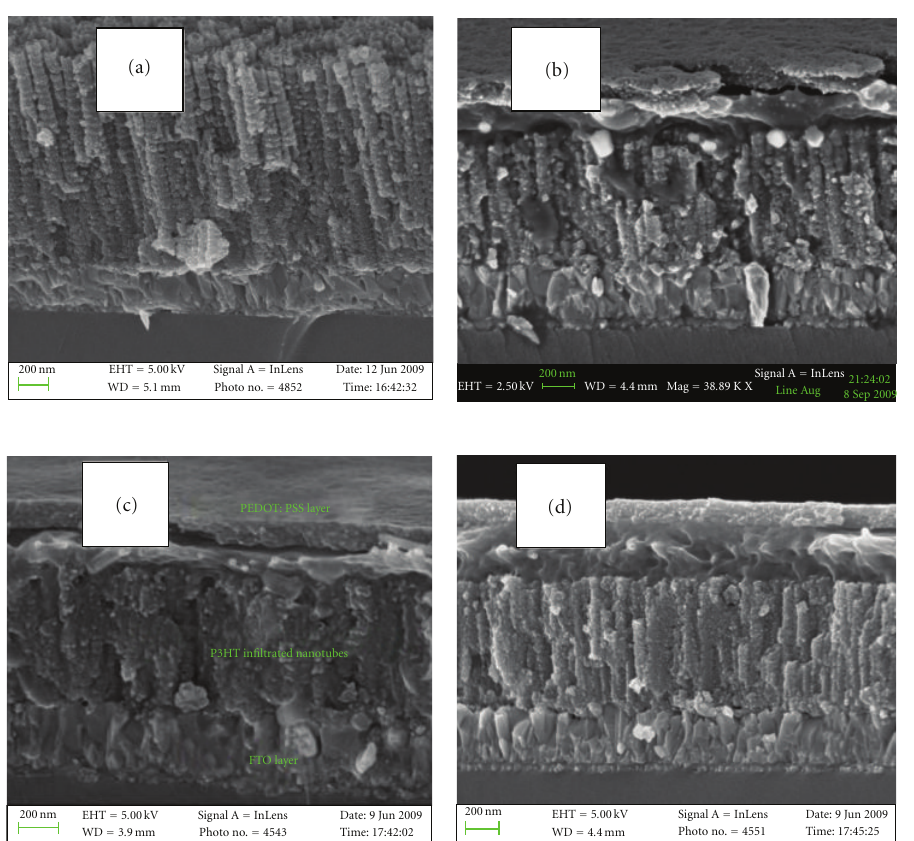
Figure 10: (a) Typical cross-sectional view of 60 nm pore size, 1–1.2 μ m length TiO 2 nanotube array film after TiCl 4 treatment. Cross- sectional FESEM image of TiO 2 nanotube ( ≈ 35nm pore size, ≈ 600–700 nm nanotube length)/SQ-1 dye/P3HT/PEDOT:PSS photovoltaic devices showing: (b) nanotubes partially infiltrated with polymer, fabricated under the condition of excess wetness; (c) fully infiltrated nanotubes fabricated under optimized wetness condition; and (d) partial infiltration of the P3HT polymer within the nanotubes, fabricated under dry condition. Reprinted with permission from